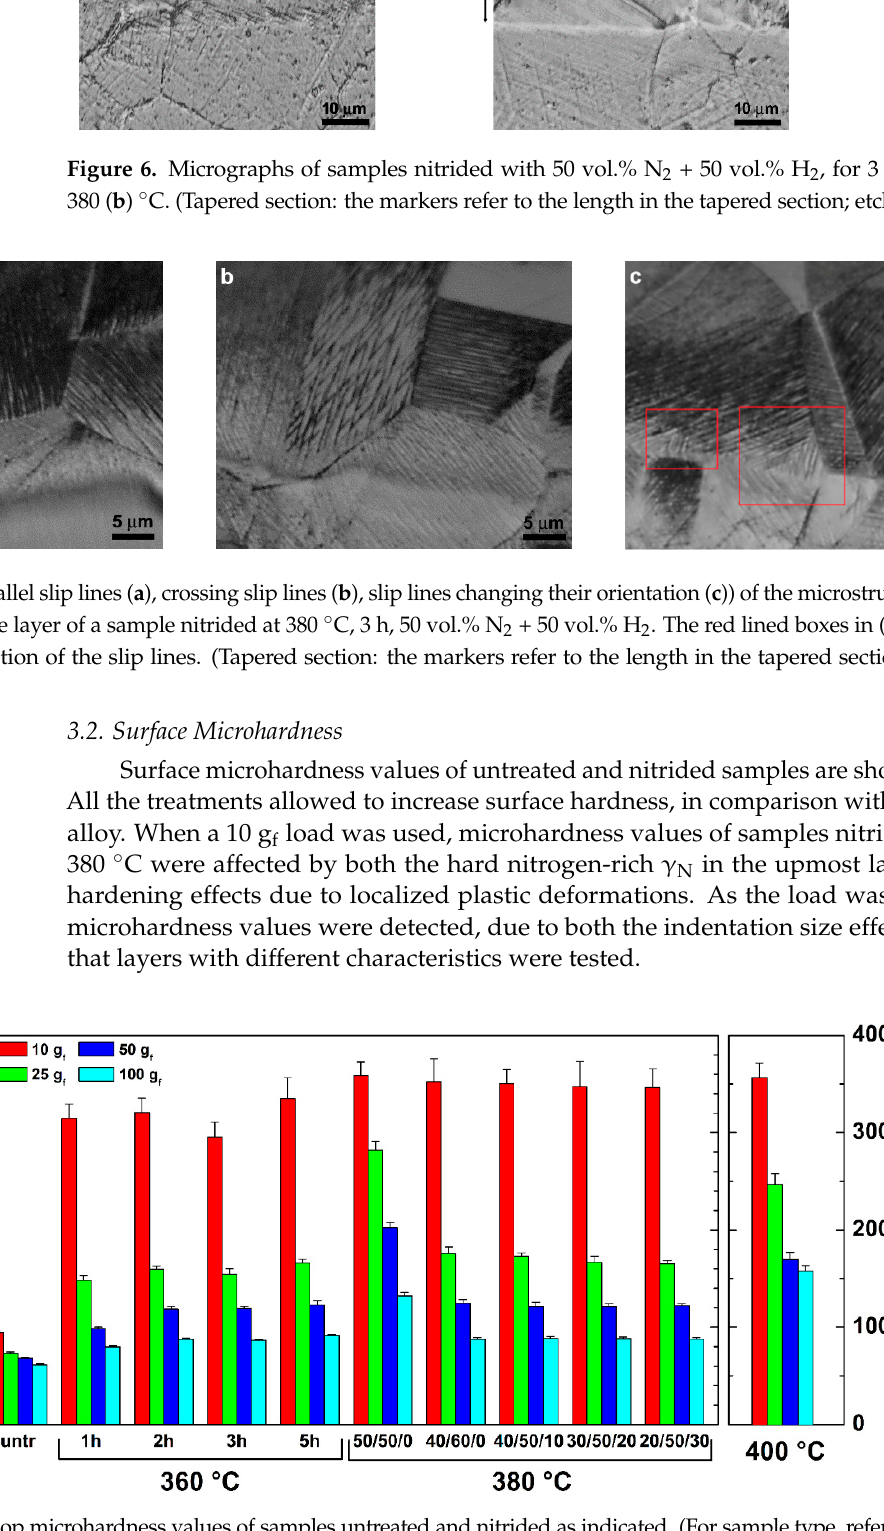
Figure 5. Surface morphology of samples nitrided at 360 °C, 50 vol.% N 2 + 50 vol.% H 2 , for 3 ( a ) and 5 ( b ) h, and at 380 °C, 3 h, with 50 vol.% N 2 + 50 vol.% H 2 ( c ) and 20 vol.% N 2 + 50 vol.% H 2 + 30 vol.% Ar ( d ). The red lined box evidences the change from a parallel pattern of the slip lines to a quadratic one.